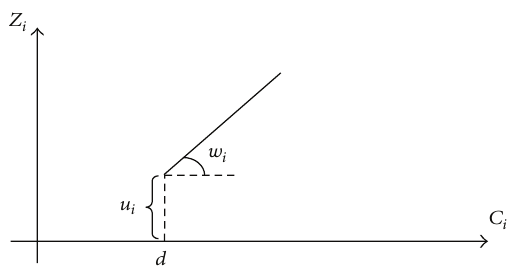
Figure 1: Biased tardiness penalty for job 𝑖